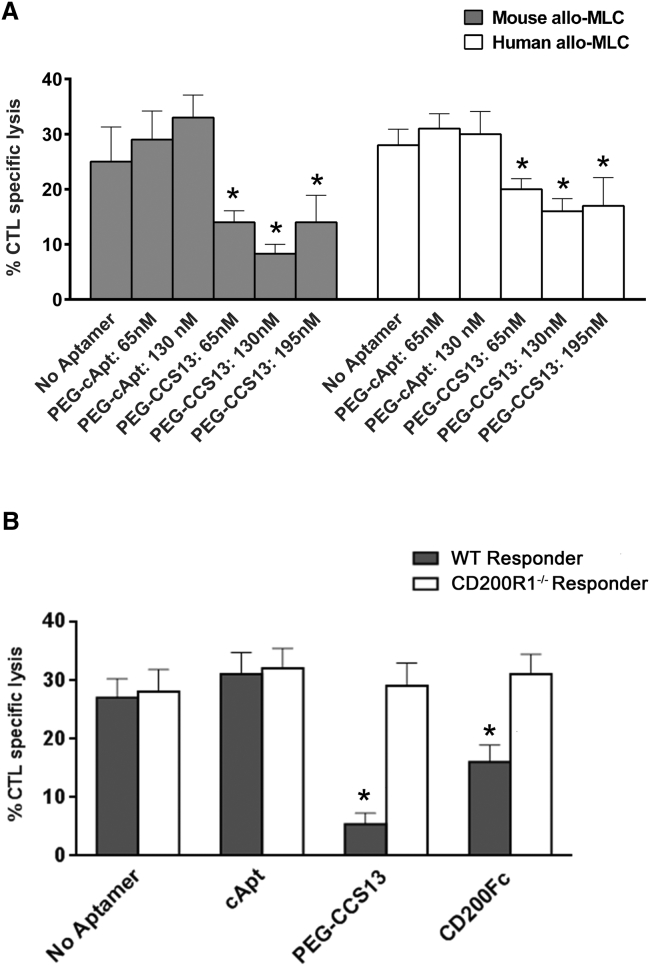
PEGylated Aptamer CCS13 Suppresses Allo-immune Responses through CD200R1(A) Attachment of a 20-kDa linear polyethylene glycol appendage at the 3′ end of the DNA aptamer CCS13 does not abrogate its ability to block CTL activity in both murine and human allo-MLCs. (B) PEGylated CCS13 blocks the activity of murine lymphocytes recovered from WT C57BL/6 mice but not from CD200R1−/− mice. Each bar represents the mean % value of CTL specific lysis ± SD. *p < 0.05, as compared to no aptamer.